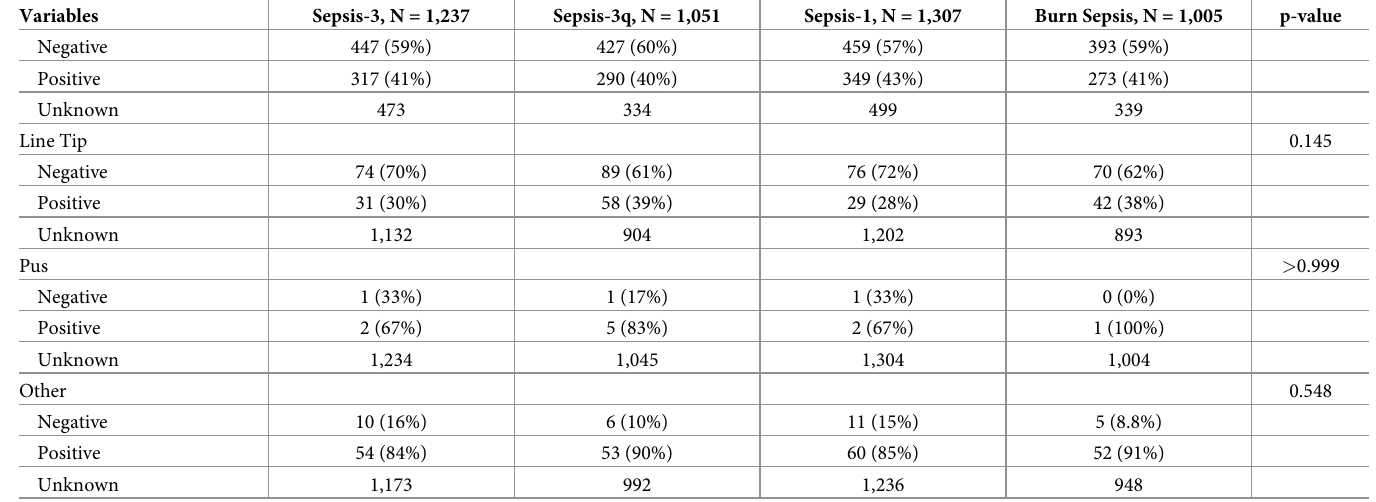
(2.426, < 0.001), Sepsis-3q (7.198, p < 0.001), and Sepsis-1 (0.575, p < 0.001) were statistically significant, with the latter showing a negative prediction. The HR of BS (0.966, p = 0.775) was below 1 and was not statistically significant. Adjusting its HR for known predictors such as age, TBSA, and inhalation injury, lowered its value, indicating that BS may be affected by burn factors but not by sepsis itself (Fig 2; S1 Table in S1 File). The mortality in each sepsis subgroup was 30.0% in BS, 30.0% in S3q, 25.7% in S3, and 24.2% in S1 (S3 Fig in S1 File).